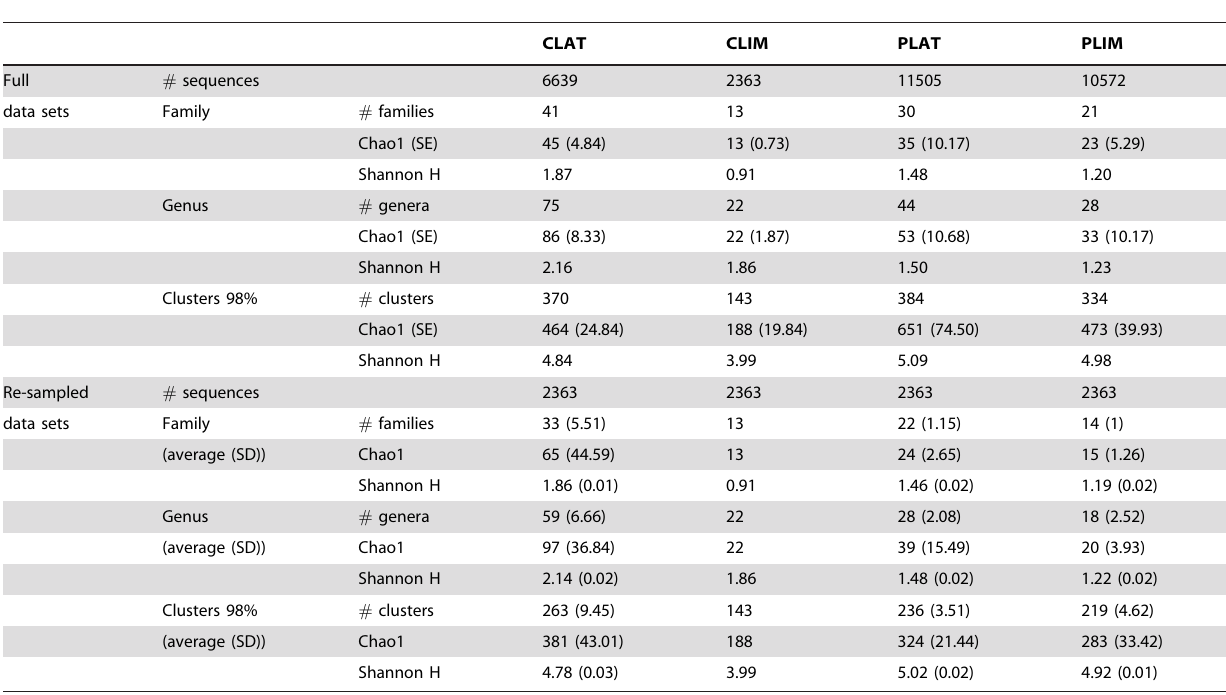
Table 1. Observed richness, Chao1 richness estimator (and standard error, SE), and Shannon diversity index (H) in larval guts (CLIM: C. limbipenne , CLAT: C. latum ) and in decayed cactus stems (PLAT: I. dumortieri decayed tissues with C. latum larvae, PLIM: I. dumortieri decayed tissues with C. imbipenne larvae) for the full data sets and re-sampled data sets adjusted by the smallest sample size (average value and standard deviation, SD, for three